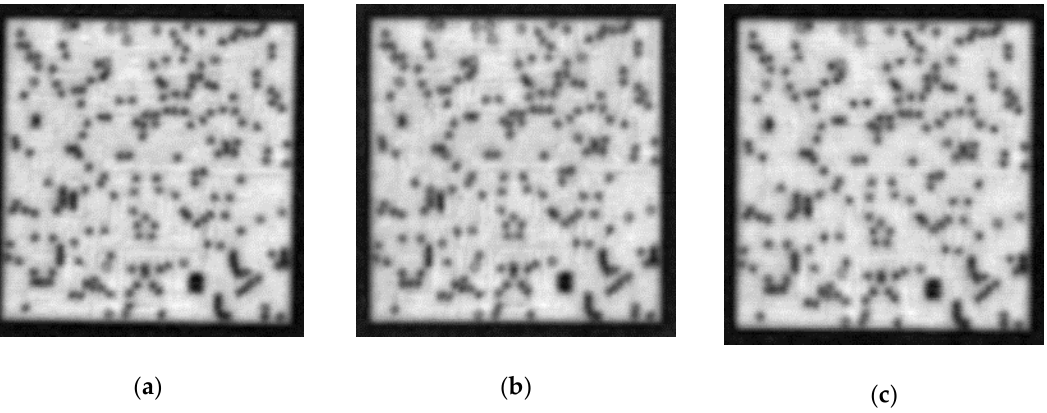
Figure 13. Results of template extraction for three SAT images: ( a ) img01 ; ( b ) img02 ; ( c ) img03 . Table 1. Numerical results of die pattern detection.